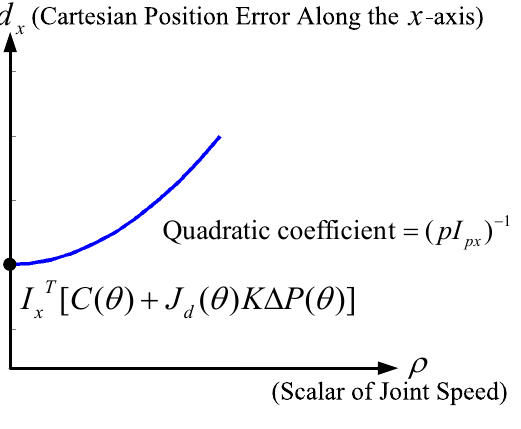
Figure 2. Quadratic function of the Cartesian position error of the end-effector of a robot along the x -axis ( d ) with respect to the scalar of the joint velocity ( ρ ), where the quadratic x ) − 1 and ˙ θ = ρ ˙ θ coefficient is ( pI px d 0